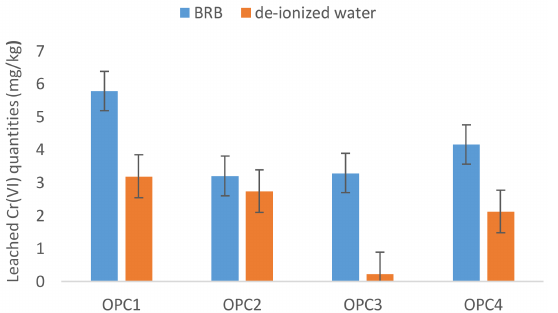
Figure 1. A comparison of the Cr(VI) leached amounts from cements in deionized water and Britton-Robinson Buffer